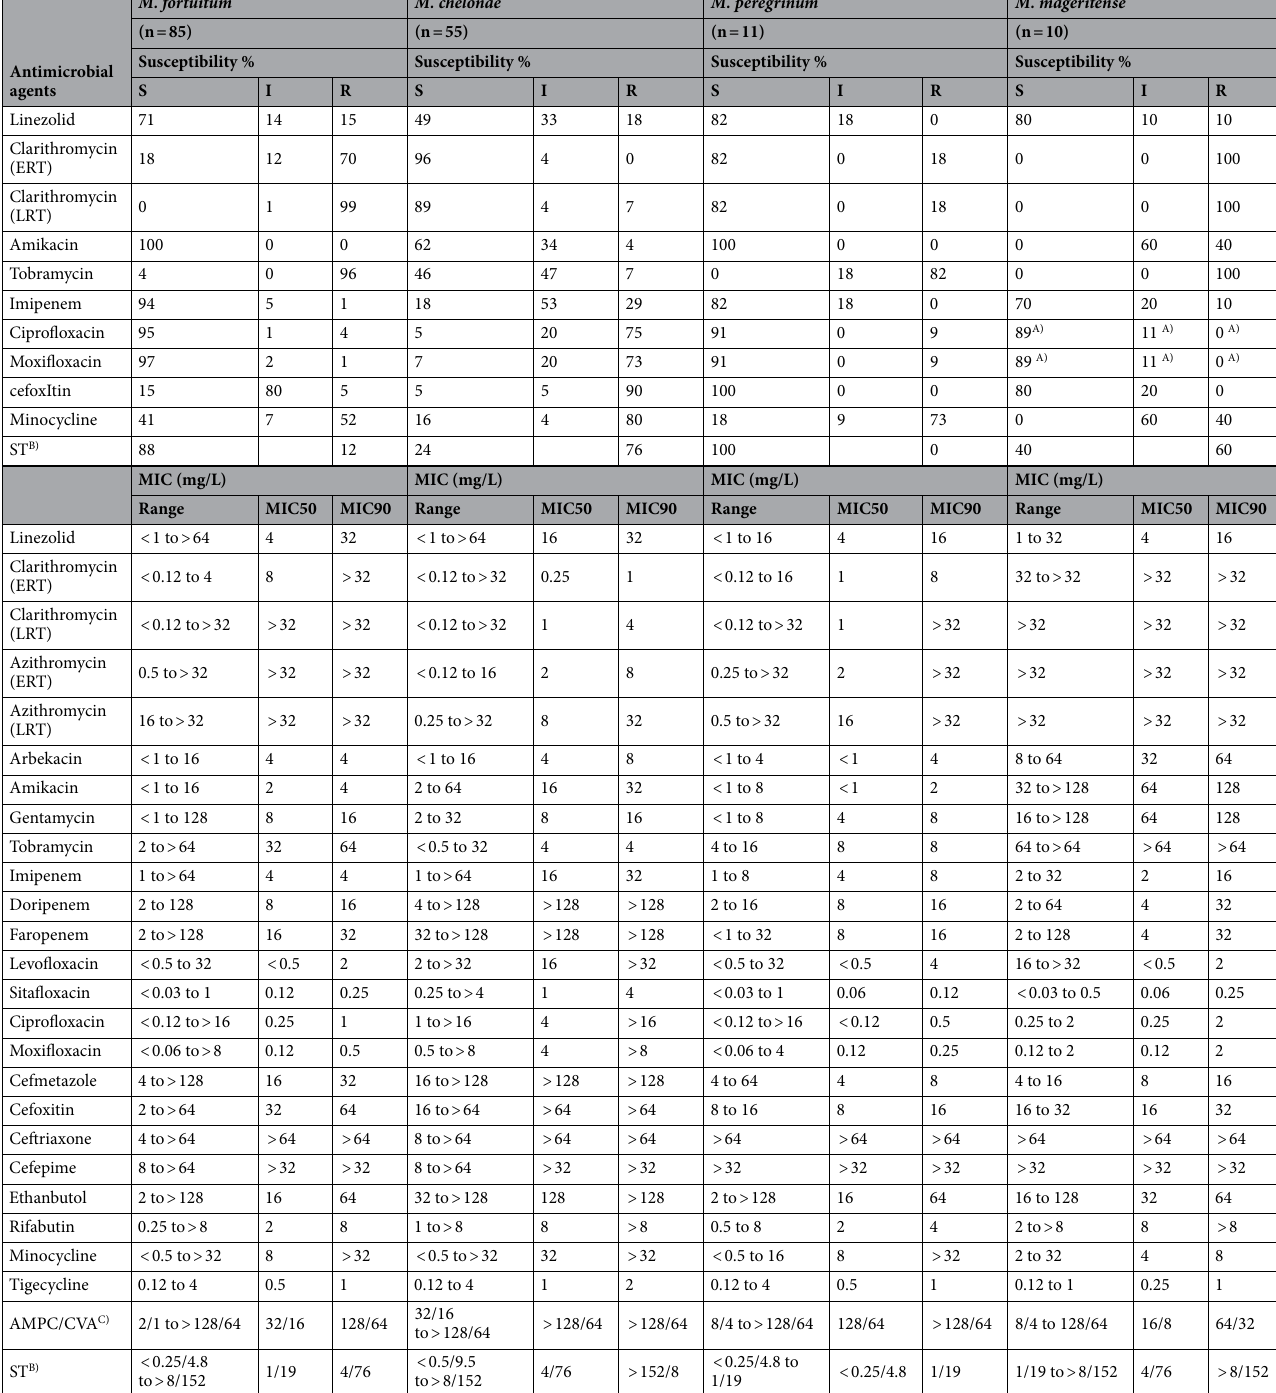
Table 3. Antimicrobial susceptibility of major rapidly growing mycobacteria (RGM) strains other than M. abscessus group (MAG). A) Minimum inhibitory concentration (MIC) for ciprofloxacin and moxifloxacin could not be determined for one strain. B) Trimethoprim/sulfamethoxazole. C) Amoxicillin/clavulanic